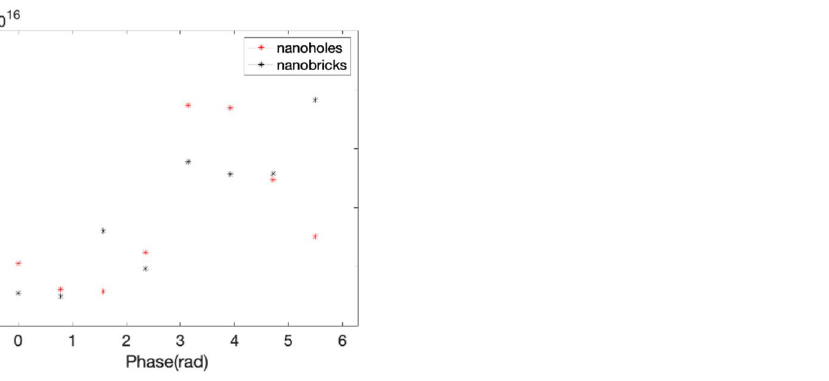
Figure 6. The mean absorption efficiencies of the selected unit-cells, which are defined as absorbed power per cubic meter, normalized to the source power.